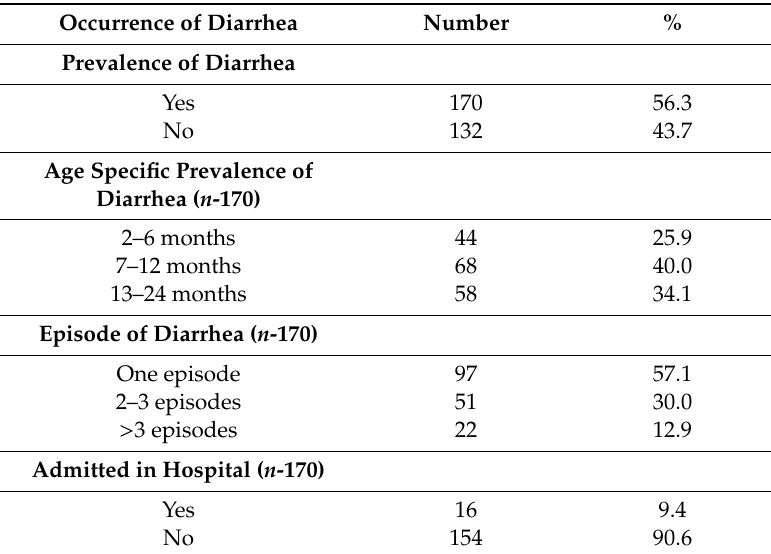
Table 3. Occurrence of diarrhea in the children.